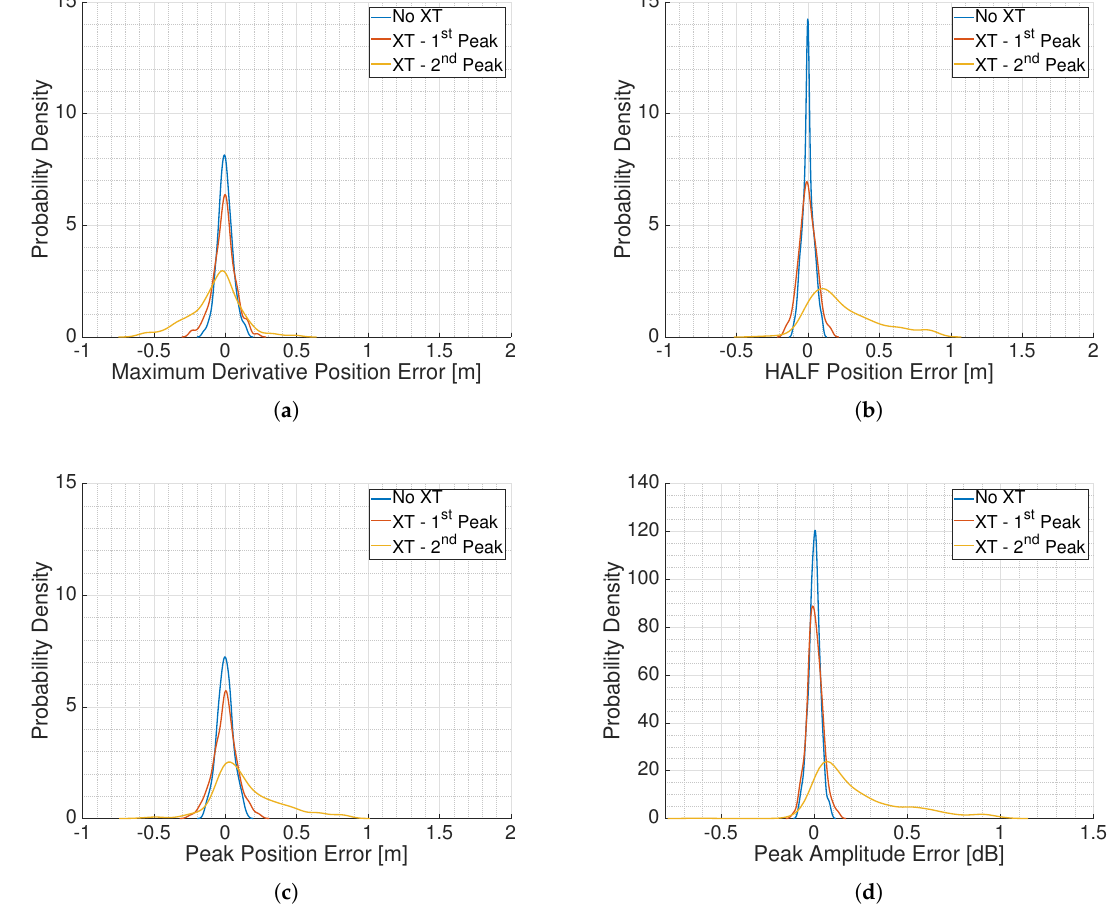
Figure 6. Probability density function (PDF) of the estimation error of the ( a ) maximum derivative position (DER), ( b ) half-power position (HALF), ( c ) peak position (MAX), and ( d ) peak amplitude. The “XT” PDFs show the error estimation when the cross-correlation peaks are close enough to interfere with each other, while the “NOXT” show the error estimation when the cross-correlation peaks are far enough not to interfere. The analysis distinguishes between the interfering cross-correlation peak arriving later than the tracked satellite cross-correlation peak (“first peak”), or arriving sooner (“second